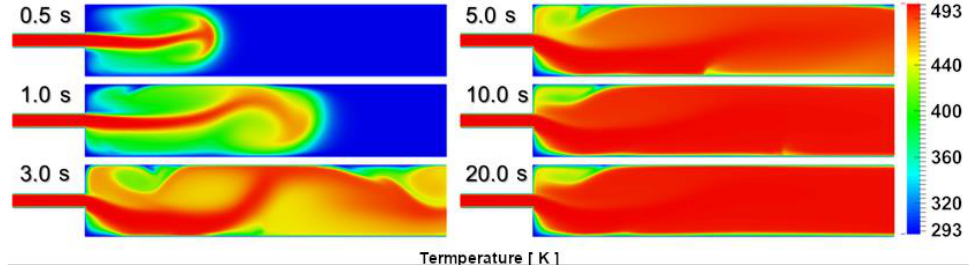
Figure 4. The volume fraction fields of the solid component at different time steps with considering the gravity and using the proposed particle flux model.